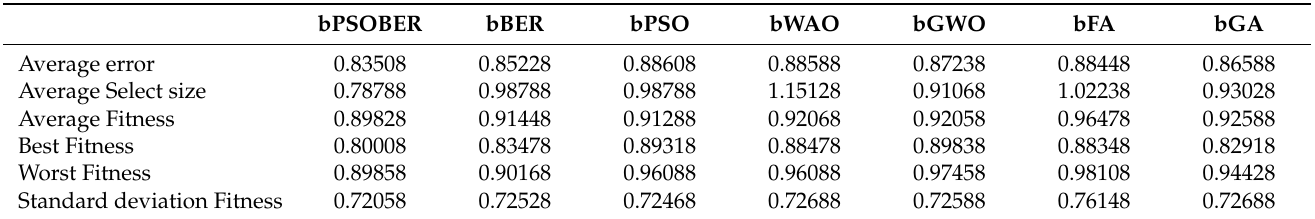
Table 6. Evaluation of the proposed feature selection algorithm (bPSOBER) compared to other competing methods.